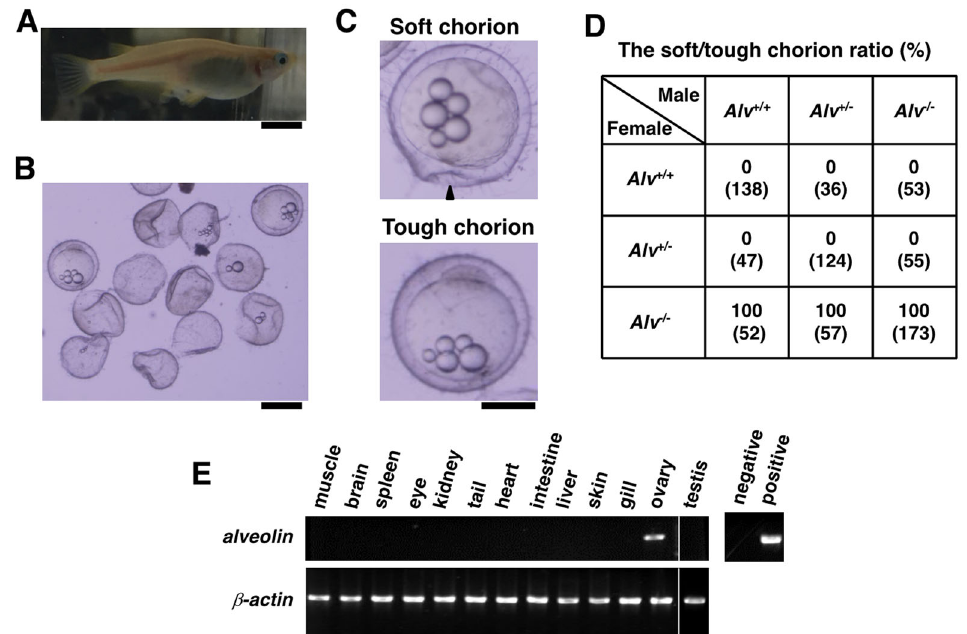
Figure 2. Soft chorion phenotype of the Alv − / − eggs. ( A ) Spawned eggs attached at the genital pore of the Alv − / − female at 1–2 h-post-fertilization (hpf). The scale bar, 10 mm; ( B ) The spawned eggs attached on the female in ( A ). Most eggs (90%) were crushed and very few could survive. The scale bar, 1 mm; ( C ) Upper , A survived Alv − / − egg. Its chorion was very soft and deformed when gently pricked with the tip of forceps (arrowhead). Lower , a WT egg. The phenotype of Alv − / − egg is named “soft chorion,” while that of WT is “tough chorion”. The scale bar, 0.5 mm; ( D ) The soft chorion/tough chorion ratio in reciprocal crossing experiments. The numbers in the parentheses stand for the number of fertilized eggs observed. ( E ) Organ ‐ specific expression of the alveolin gene as detected by RT ‐ PCR. The actin gene expression was also shown. The size of amplicons is 804 and 840 bp for alveolin and β‐ actin genes, respectively. Negative and positive controls were water and a pGEM ‐ alveolin plasmid used as a template, respectively.